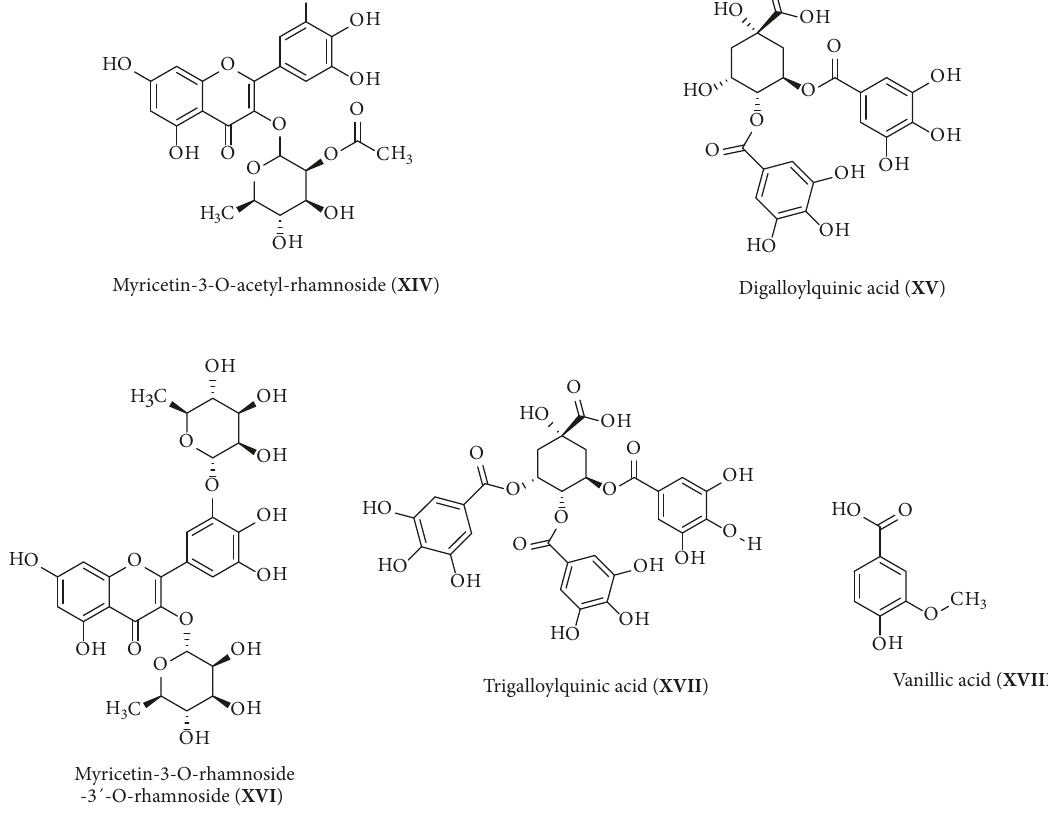
Figure 3: Compounds identified in subfractions F2-F7.